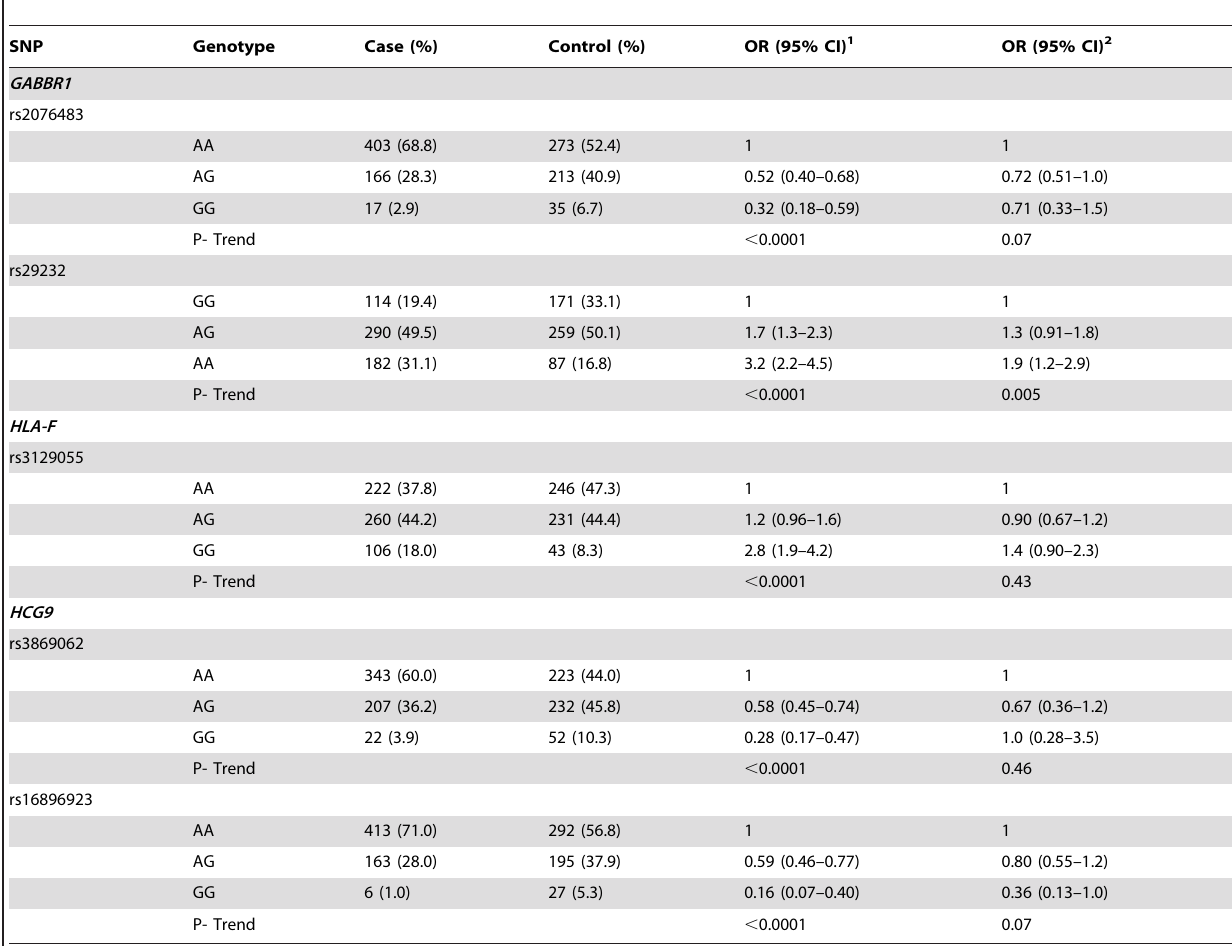
Table 1. Pooled Distribution, Odds Ratios and 95% Confidence Intervals for the Association Between Chromosome 6p21 TagSNPs and NPC.